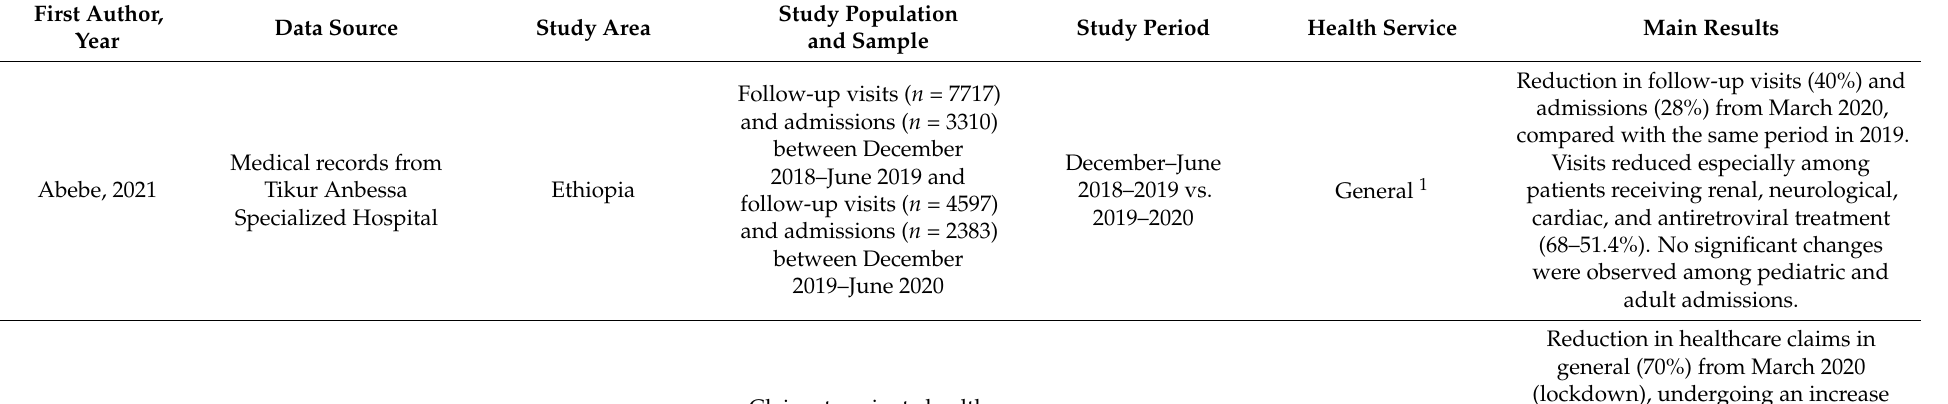
Table 1. Changes in the utilization of health services and influencing factors during the COVID-19 pandemic in